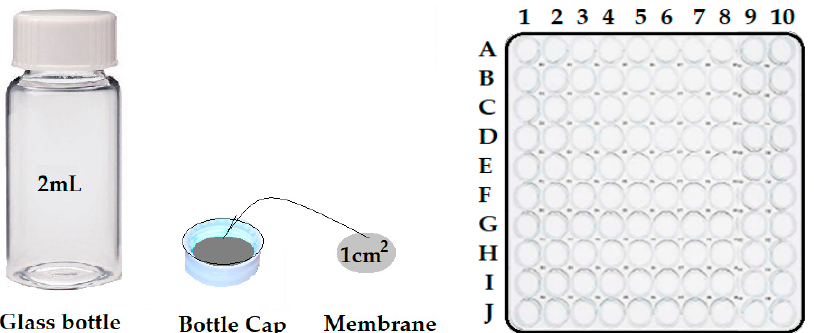
Figure 4. Schematic representation of the membrane arrangement of the lid and the positioning of the sample bottles for the controlled release of silver ions/10–undecenoic acid. the sample bottles for the controlled release of silver ions/10–undecenoic